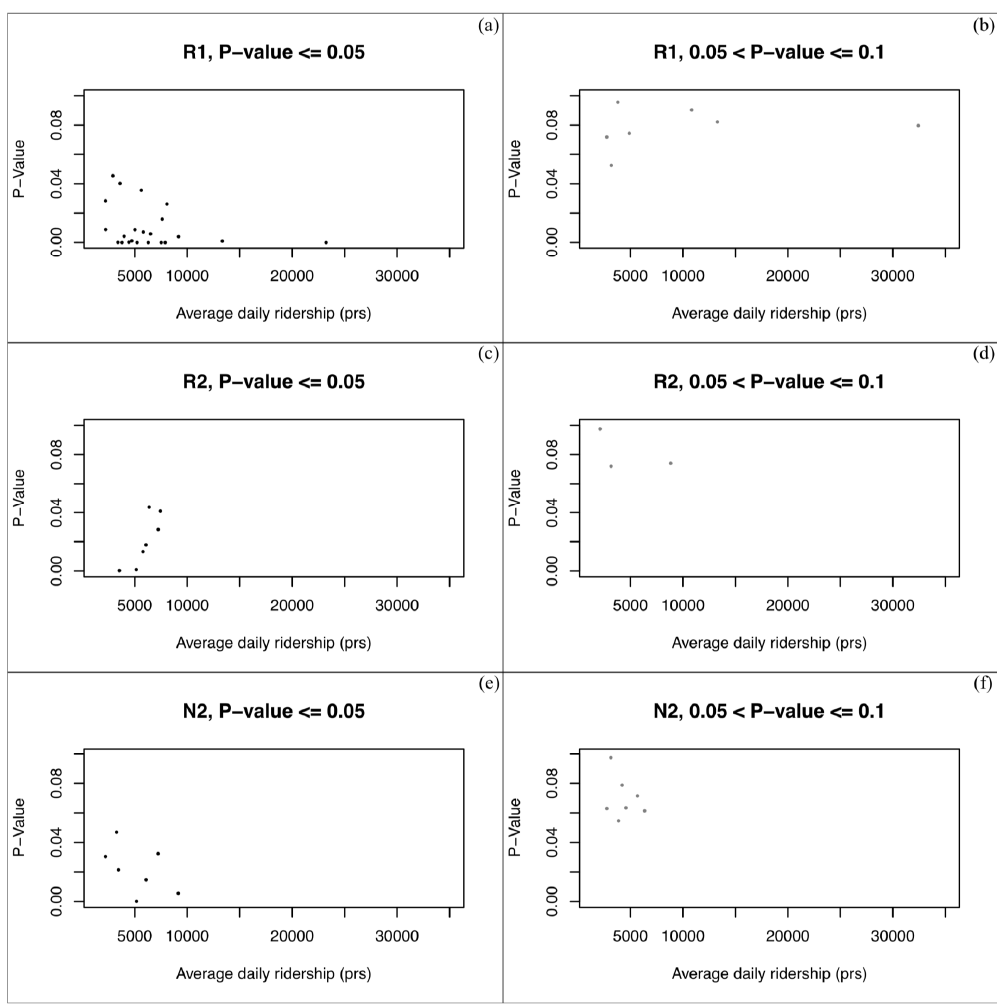
Figure 5. ( a ) Distribution of the average ridership of stations with p ‐ values <0.05 during R1; ( b ) distribution of the average ridership of stations with p ‐ values between 0.05 and 0.1 during R1; ( c ) distribution of the average ridership of stations with p ‐ values <0.05 during R2; ( d ) distribution of the average ridership of stations with p ‐ values between 0.05 and 0.1 during R2; ( e ) distribution of the average ridership of stations with p ‐ values <0.05 during N2; and ( f ) distribution of the average ridership of stations with p ‐ values between 0.05 and 0.1 during N2.